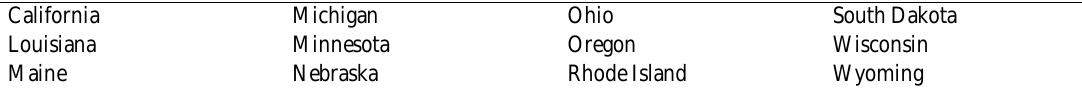
Table 1. States that require adapted physical education certifications.